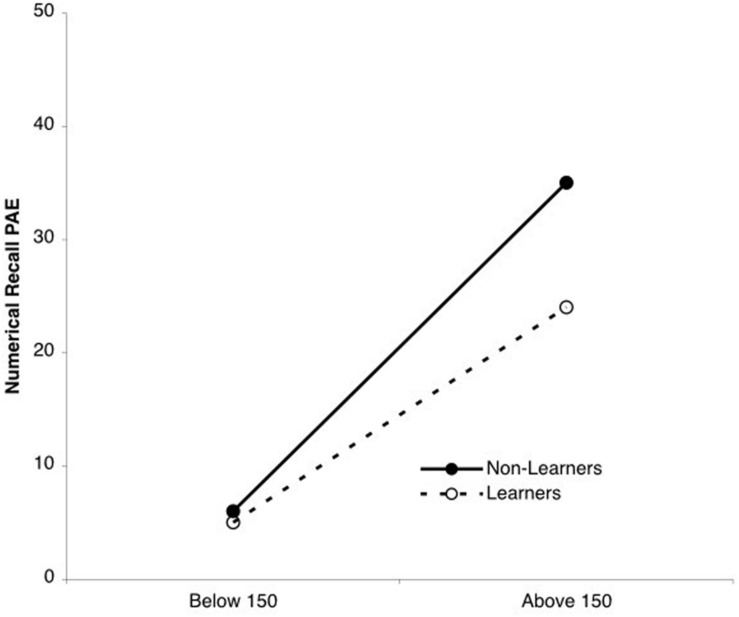
Numerical range × learner status interaction. Regardless of whether children had learned to produce a linear series of estimates on the number line estimation task, smaller numbers were remembered better than were larger ones. However, children who learned to produce a linear series of estimates remembered bigger numbers better than those children who did not learn to produce a linear series of estimates.